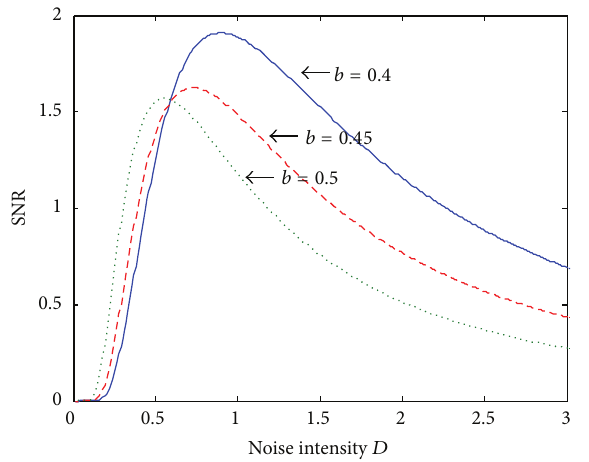
Figure 5: SNR versus noise intensity 𝐷 for different system parameters 𝑑 : 0.03, 0.036, and 0.042. Other parameters are 𝑏 = 0.52 and 𝑐 = −0.31 .